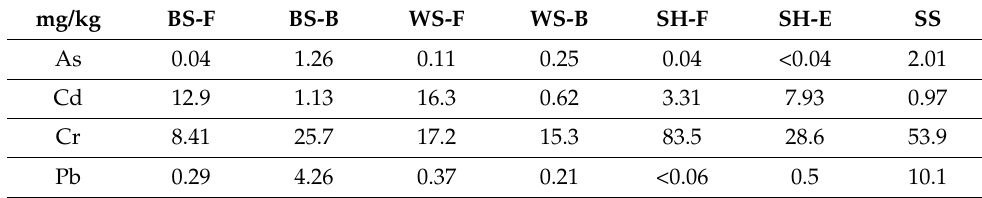
Table 6. Heavy metal content in ABAs.